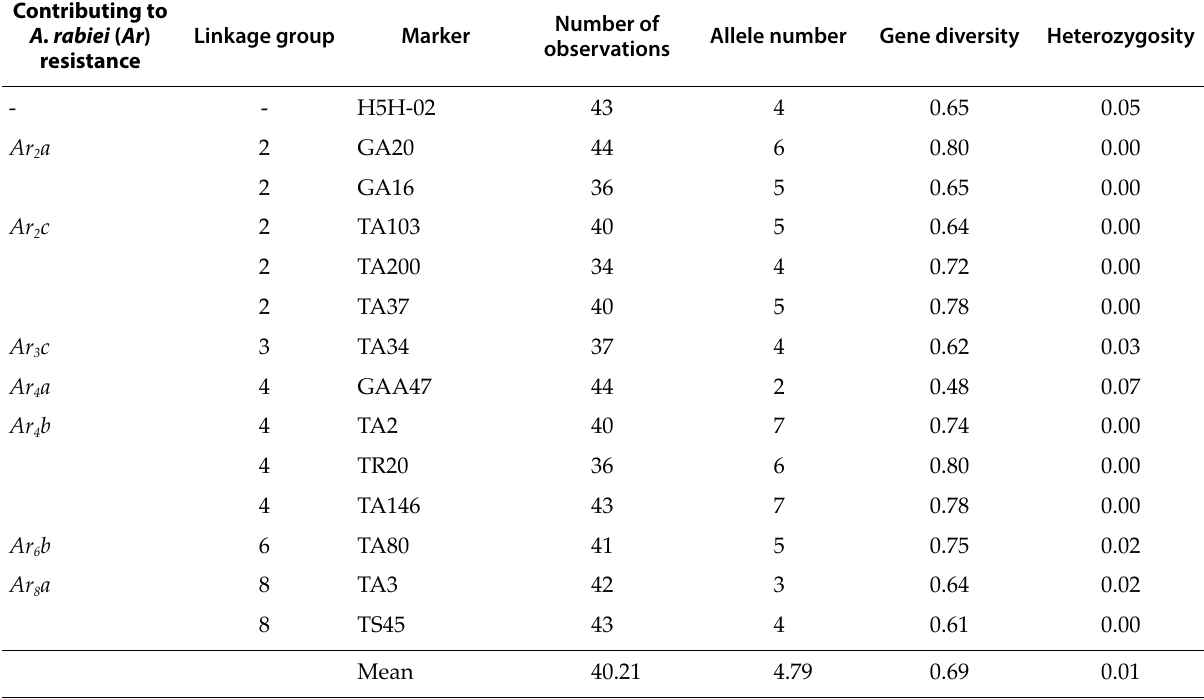
Table 3. Variation at microsatellite loci used to study the genetic diversity of 43 chickpea genotypes, resistant and suscep - tible to Ascochyta